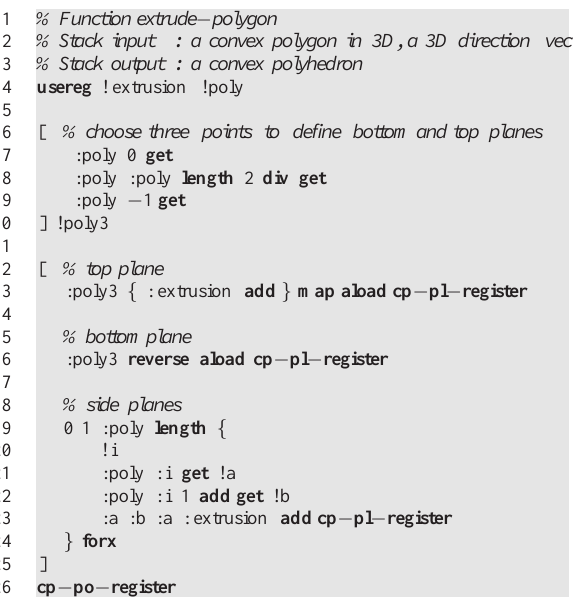
Figure 4: A solid convex region in 3D space is the intersection of halfspaces (oriented planes). Each plane divides space into unbounded interior and exterior. (a) The solid is the intersection of all interiors. (b) With this plane based representation, a part of a cube can be clipped away simply by adding another halfspace.